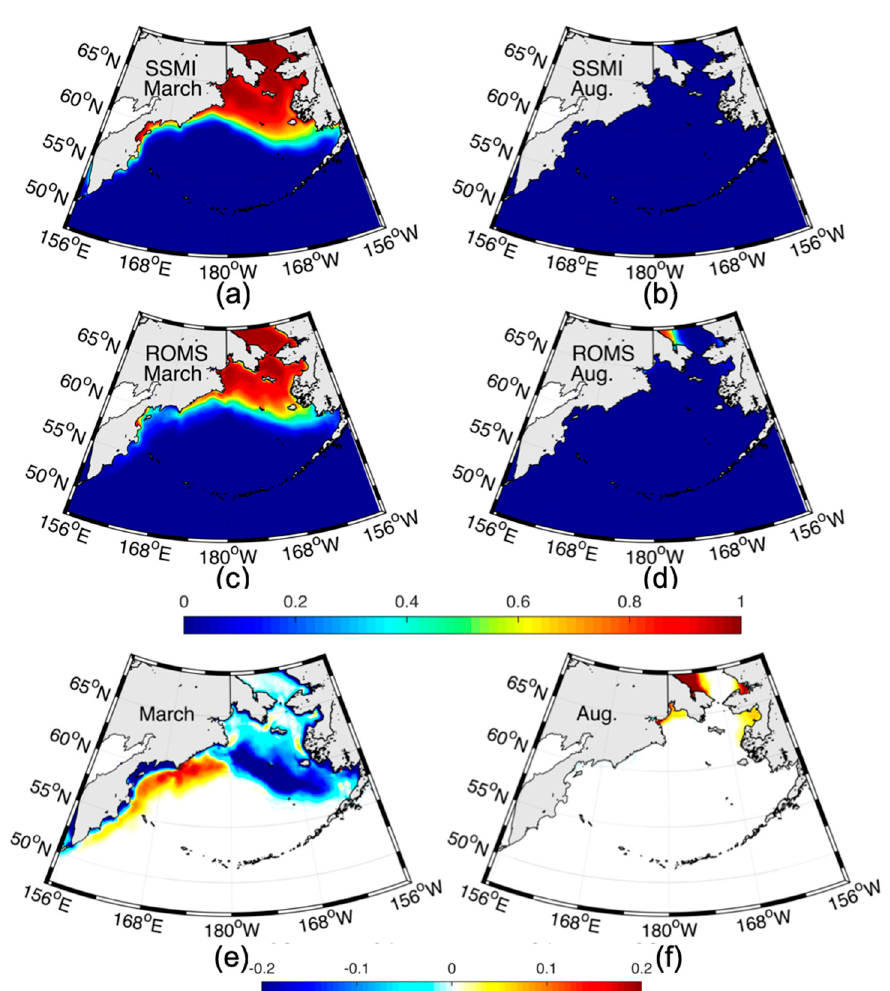
Figure 3. Seasonal variation in the sea ice coverage percentage in the Bering Sea averaged over 15 years (1990–2004): ( a ) March and ( b ) August are derived from the SSM/I data; ( c ) March and ( d ) August are derived from the ROMS results. The differences (ROMS minus SSMI) between ROMS and SSM/I are presented for ( e ) March and ( f ) August. The model resolution is about 5 km (averaged) and the SSM/I resolution is 25 km.